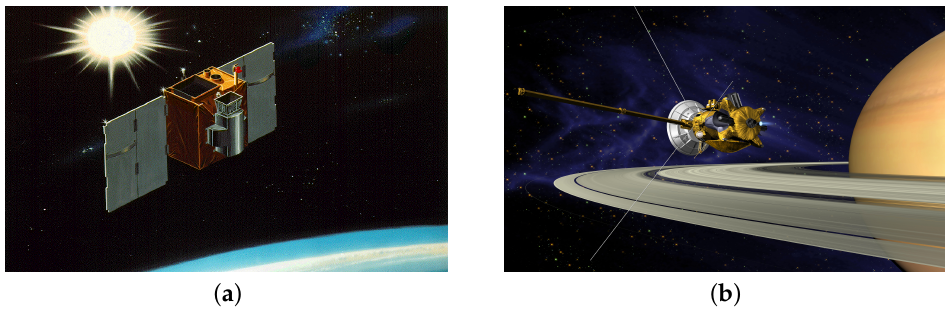
Figure 2. ( a ) SAMPEX Satellite, artist rendition ( b ) Cassini Satellite, artist rendition